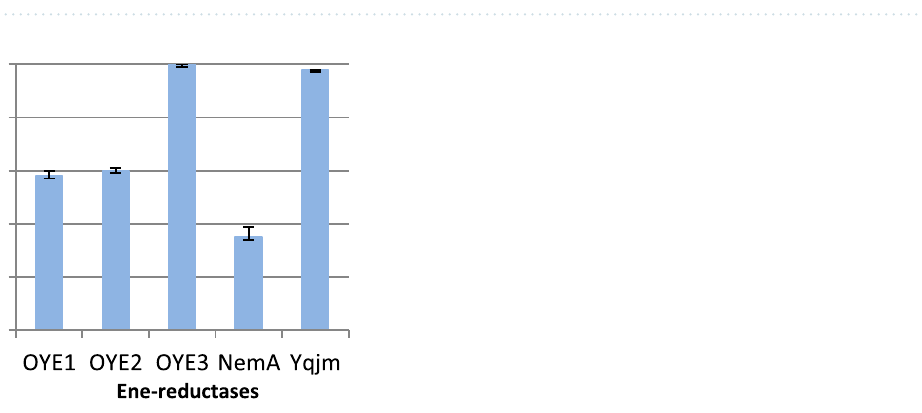
Figure 2. Results of massoia lactone ( 1 ) conversion by selected ene-reductases after 72 h (reaction conditions: 10 µL of 500 mM massoia lactone, 10 µL of 10 mM NADP + solution, 20 µL of 1 M glucose solution, and 10 µL of GDH (5 mg/mL), ene-reductase: 100 µL (OYE1—50 µL, OYE2, OYE2.6, OYE3 and NemA—40 µL), 50 mM phosphate buffer pH 7–1 mL).